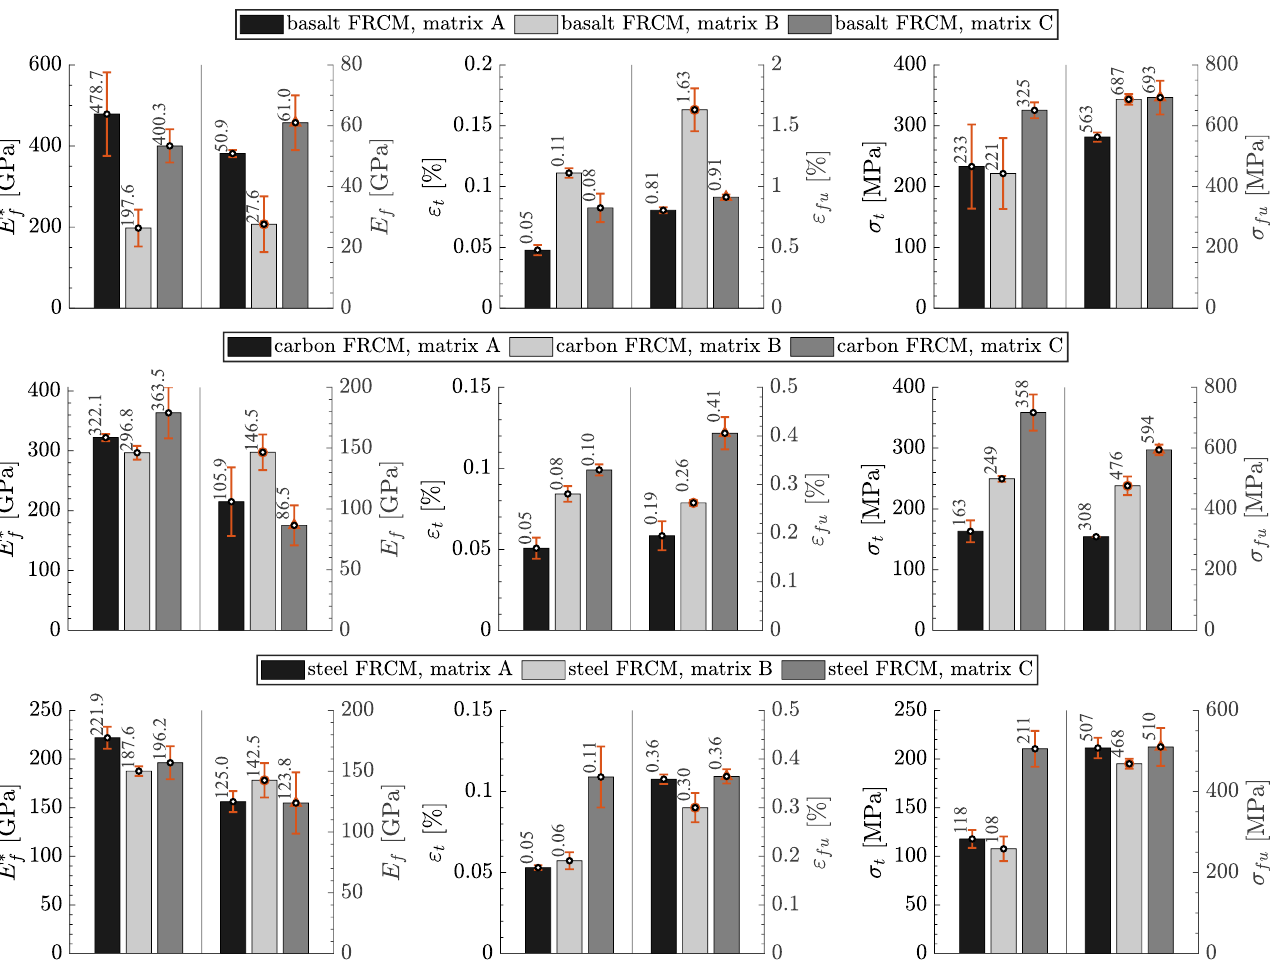
Figure 13. Uncracked ( 𝐸 𝑓∗ ) and cracked ( 𝐸 𝑓 ) elastic modulus ( left ), tensile strain ( center ) and tensile stress ( right ) at the transition point ( 𝜀 𝑡 and 𝜎 𝑡 , respectively) and at ultimate conditions ( 𝜀 𝑓𝑢 and 𝜎 𝑓𝑢 , respectively) of FRCM coupons realized with different fabrics and cement-based matrices.